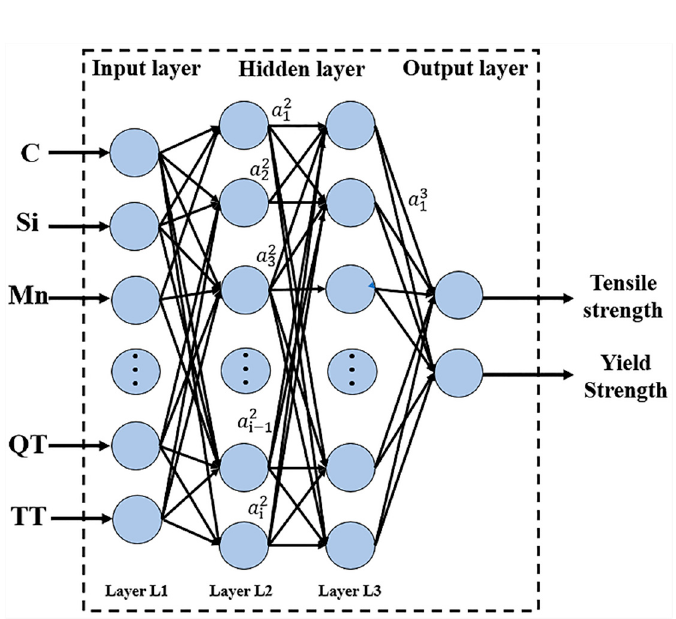
Figure 4. Deep neural network (DNN).